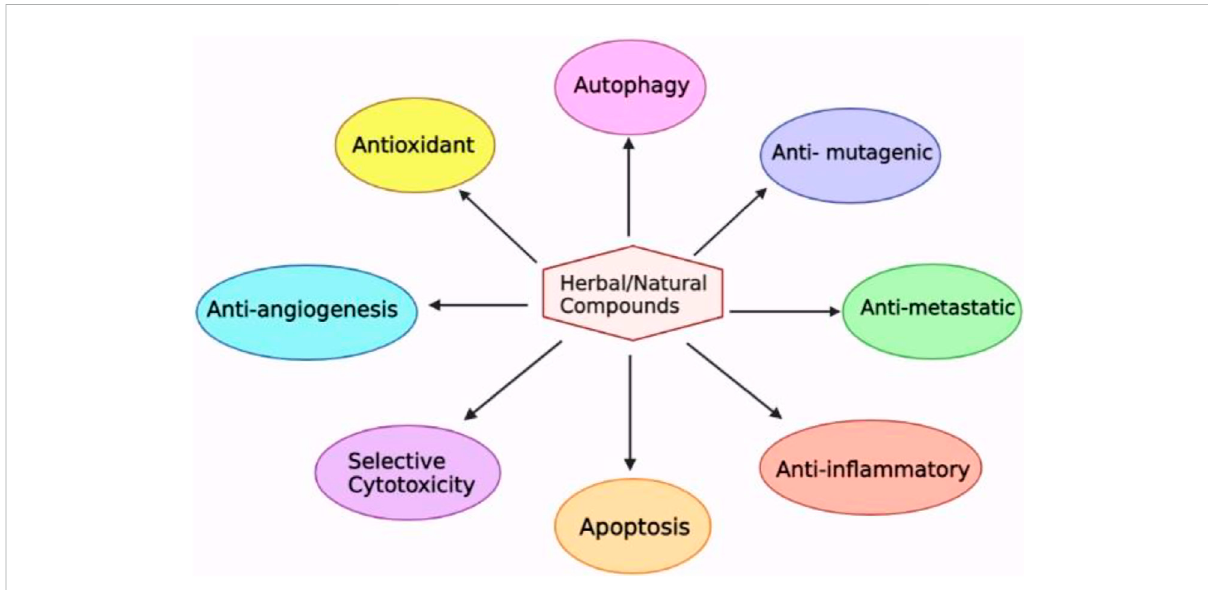
(Figure 1) . By suppressing the cell cycle, inducing apoptosis, controlling the metabolism of carcinogens and the expression of oncogenes, restricting cell adhesion, multiplication, and migratory, and blocking signaling pathways that are crucial for cancer development, dietary ingestion of a suf fi cient amount of these herbal supplements may aid in the preventive measures and treatment of cancer (Huang et al., 2009). A total of 136 anticancer medications were introduced for usage between 1981 and 2014, and about 83 percent of them were either herbal substances or their derivatives (Amaral et al.,